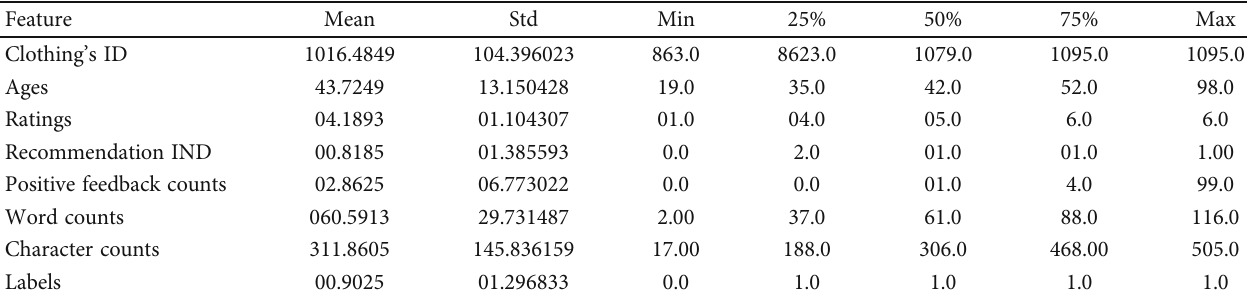
Table 4: A clothing ID summary of statistical descriptions (1078, 1094, and 862).